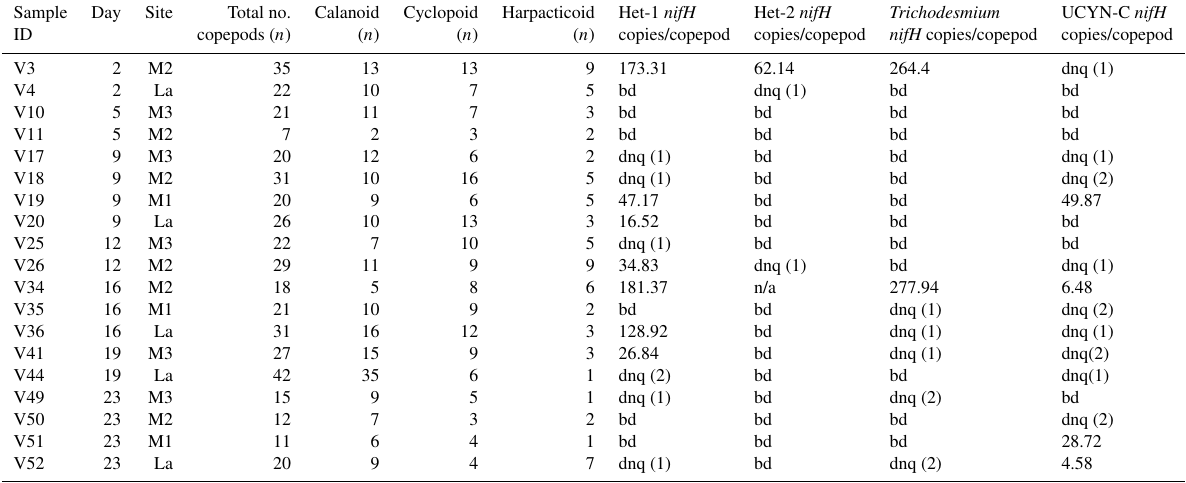
Table 1. Summary of copepod samples processed for qPCR, targeting Trichodesmium spp., het-1 and the het-2 (DDA), and unicellular group C (UCYN-C). All copepods per sample were pooled during the DNA extraction protocol. Site refers to the three VAHINE mesocosms (M1– 3) and the lagoon waters (La). Samples V3–V4 were from the period prior to phosphorous fertilisation (P0; days 0-04); samples V10–V26 were from the period dominated by DDA (het-1) (P1; days 5–14); samples V34–V52 were from the period dominated by UCYN-C (P2; days 15–23). Het-1 is Richelia associated with Rhizosolenia ; het-2 is Richelia associated with Hemiaulus ; bd is below detection; dnq is detectable but not quantifiable; number in parenthesis is number of targets hit in three